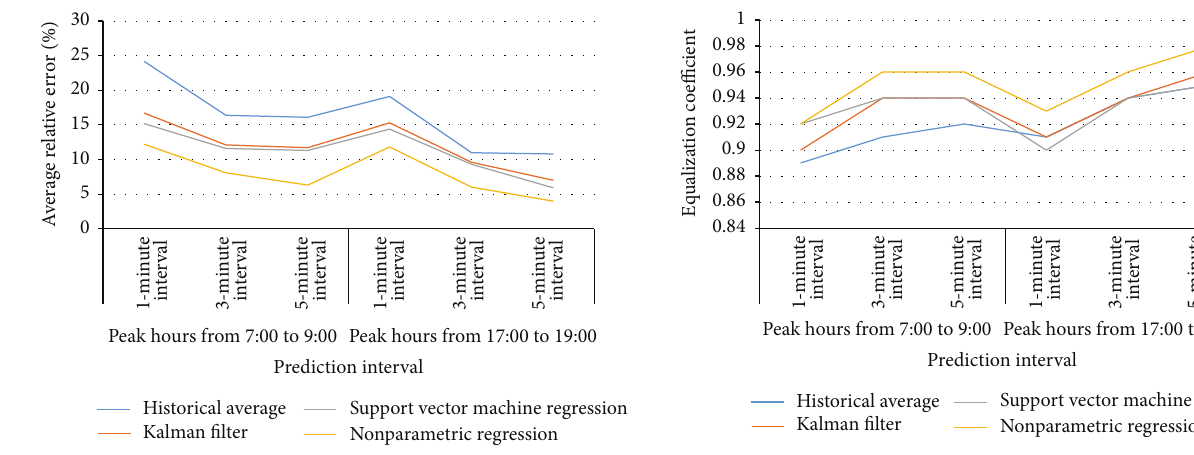
Figure 12: Comparison of equalization coefficient for different forecasting